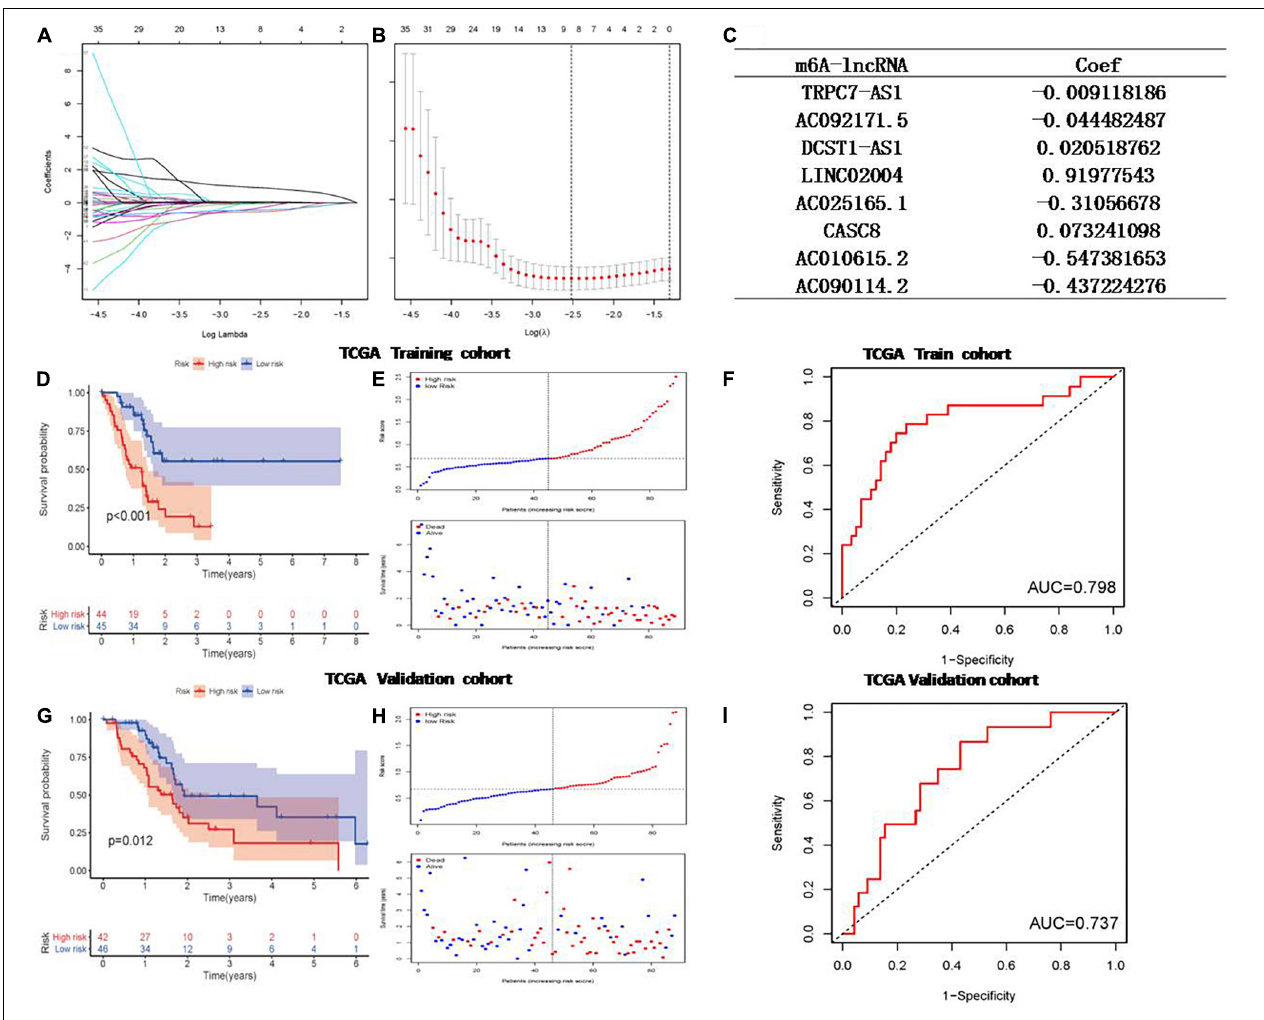
FIGURE 2 | Least absolute shrinkage and selection operator (LASSO) regression for calculating risk model for pancreatic cancer patients based on the m6A-associated lncRNAs. (A) The tuning parameters of OS-related proteins to cross-verify the error curve. (B) Perpendicular imaginary lines to calculating the minimum criteria (C) The LASSO coefficient profile of 24 OS-related m6A-lncRNA and perpendicular imaginary line. (D) Survival status of patients in different groups in training cohort. (E) Rank of prognostic index and distribution of groups based on m6A-lncRNA prognostic signature risk scores in training cohort. (F) Receiver operating characteristic (ROC) curves of the m6A-lncRNA prognostic signature for predicting the 1-year survival in training cohort. (G) Survival status in validation cohort. (H) Rank of prognostic index and distribution of groups based on m6A-lncRNA prognostic signature risk scores in validation cohort. (I) ROC curves for predicting the 1-year survival in validation